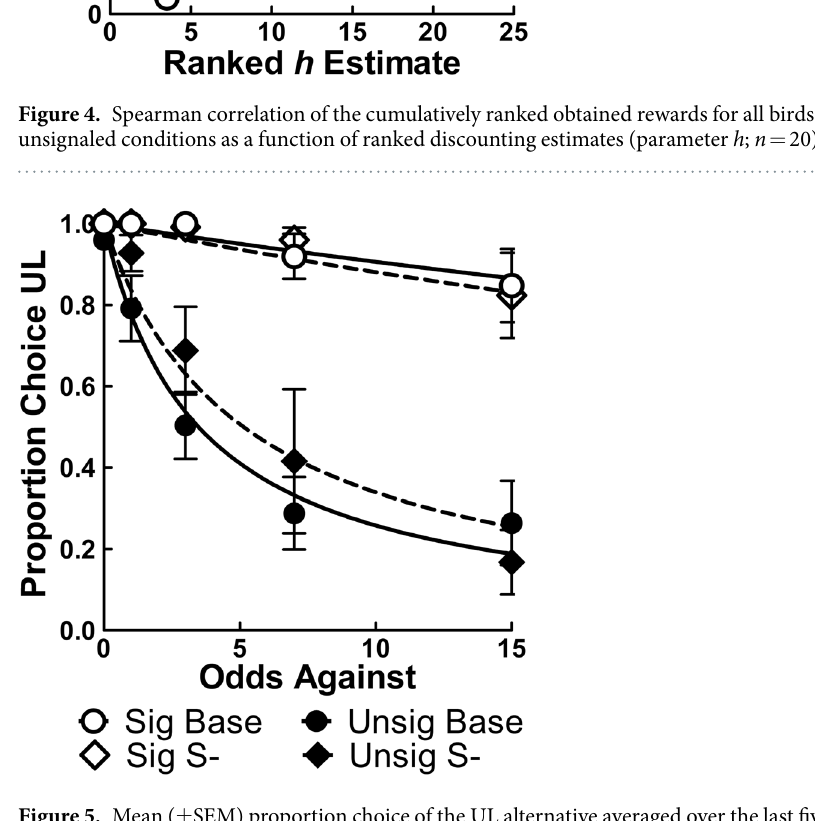
Figure 5. Mean ( ± SEM) proportion choice of the UL alternative averaged over the last five sessions of training from the reversal (circles and solid lines) and addition of the S- (diamonds and dashed lines) phases ( n =